Question: State the chart type depicted above.
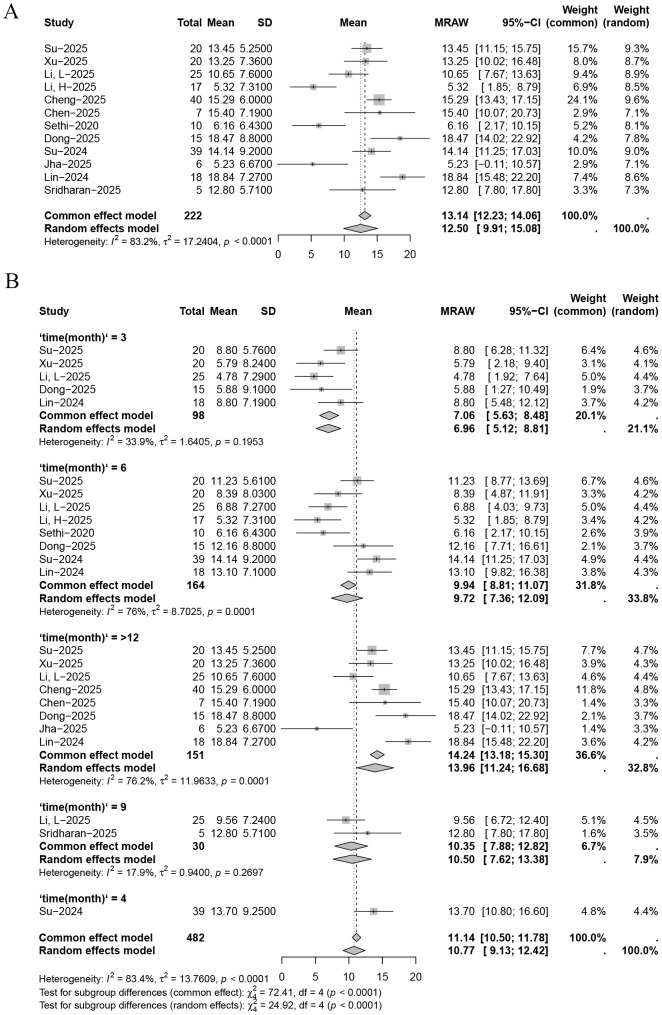
Answer: forest